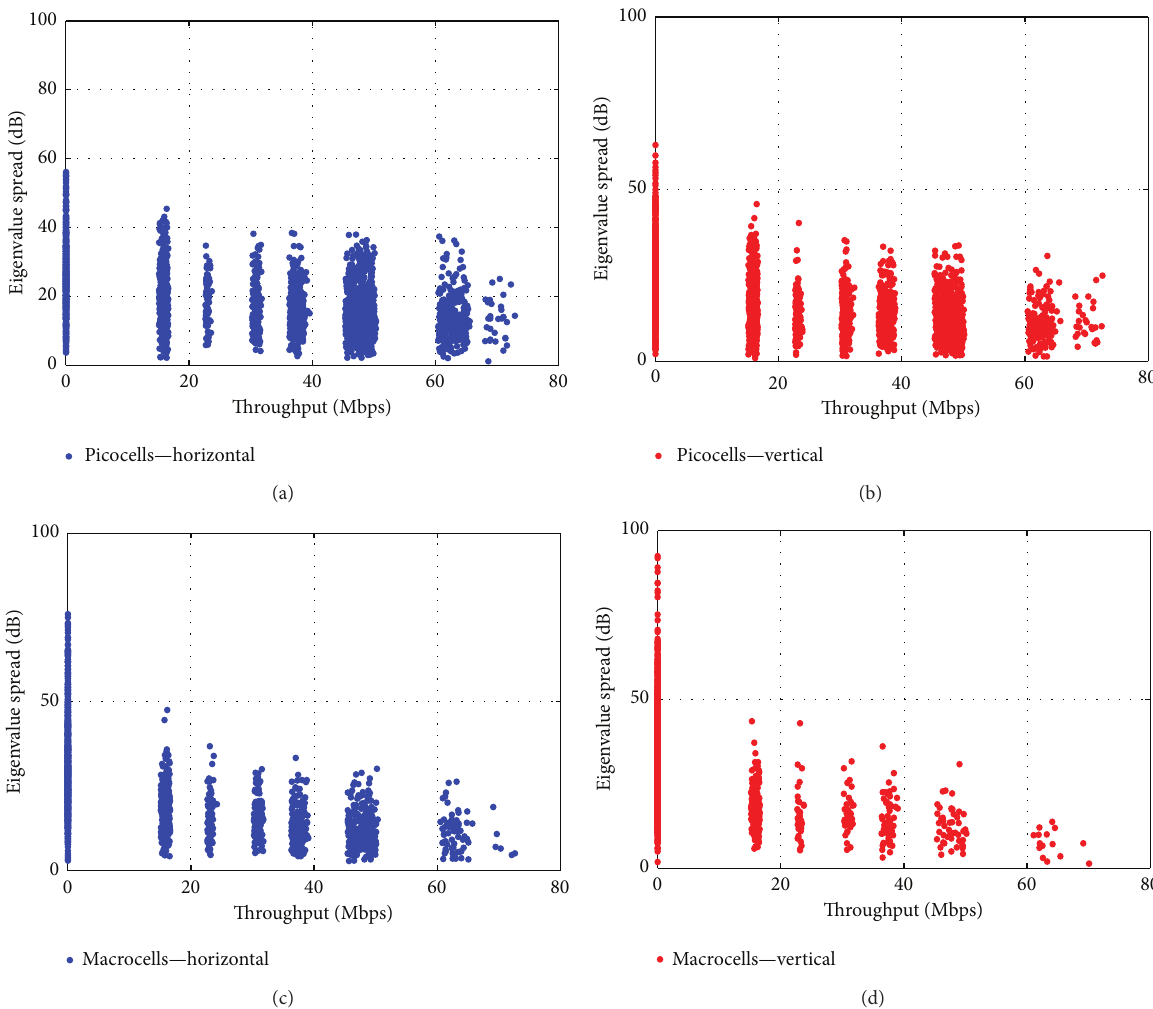
Figure 12: Scatter plot of throughput versus eigenvalue spread for picocells and macrocells with horizontal and vertical eNB antenna configurations and an antenna separation of 3𝜆 (NLoS links